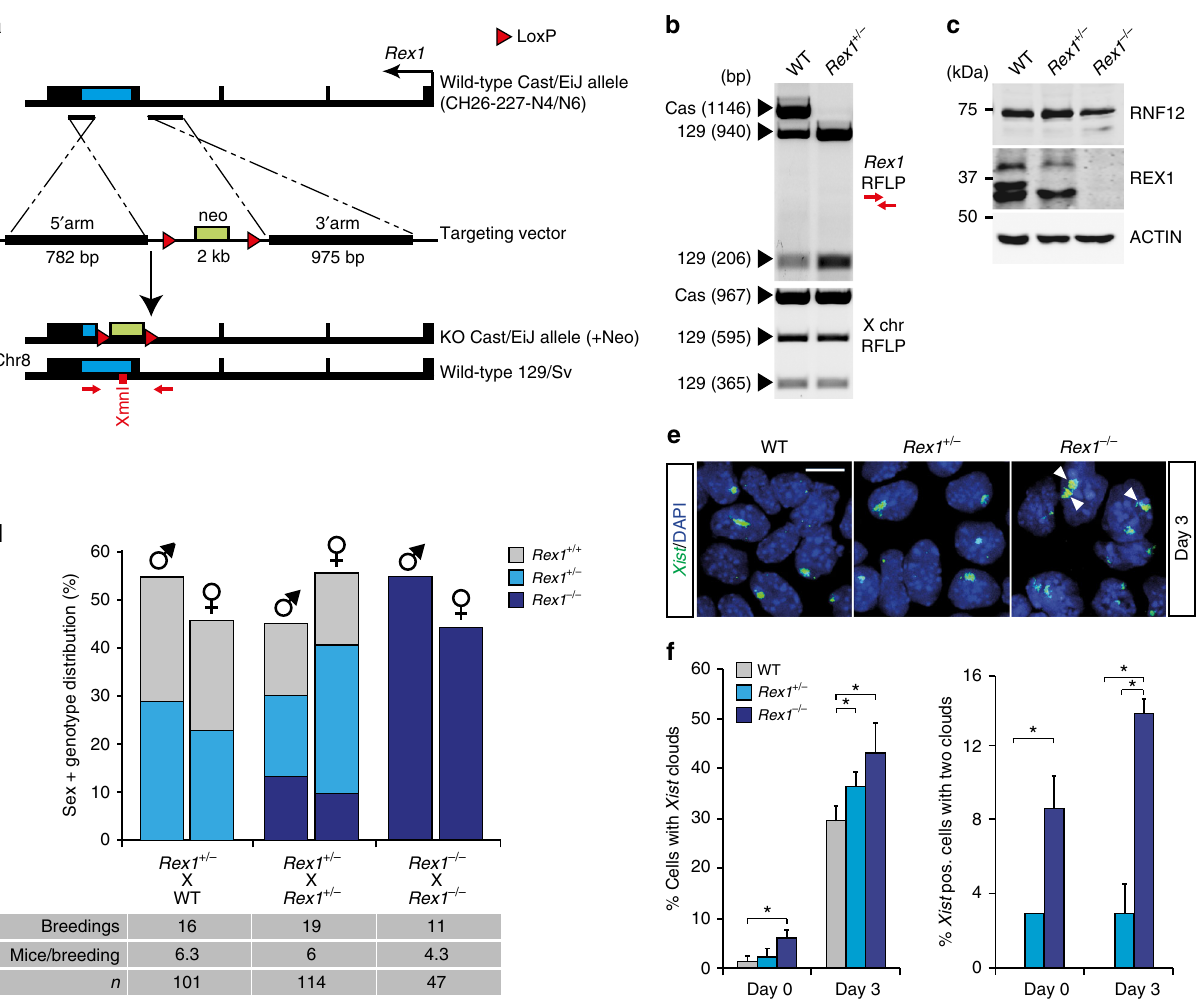
Fig. 2 Rex1 knockout mice are viable and fertile. a BAC targeting strategy to generate the Rex1 knockout cas allele in 129:cas ESCs. The Rex1 coding sequence is shown as a blue box. The start site is indicated by a black arrow. LoxP sites, denoted as red triangles, fl ank the neomycin-resistance gene (neo) as a positive gene selection marker. Primers used to validate gene recombination in ESCs and to genotype are shown as red arrows. b Validation of Rex1 knockout cas allele recombination by XmnI RFLP analysis of WT and Rex1 -targeted ESCs (top panel). Pf1M1 RFLP analysis to detect presence of two X chromosomes (bottom panel). c Nuclear extracts of WT, Rex1 + / − and Rex1 − / − ESCs were immunoblotted with RNF12 and REX1 antibodies. ACTIN was used as a loading control. Uncropped WB images are found in Supplementary Fig. 10b. d Sex and genotype distribution from different matings of Rex1 - de fi cient mice. Number of breedings, number of mice per breeding and total number of mice are indicated below. No signi fi cant bias against the birth of female animals was observed ( χ 2 test, p > 0.05). e Xist RNA-FISH (FITC) analysis on WT, Rex1 + / − and Rex1 − / − ESCs at day 3 of differentiation. DNA was stained with DAPI (blue). White arrows indicate the presence of two clouds within a nucleus. Scale bar: 20 μ m. f Quanti fi cation of Xist -positive cells (left panel) and Xist -positive cells with two clouds (right panel) in WT, Rex1 + / − and Rex1 − / − ESCs at day 0 and day 3 of differentiation. Asterisks indicate p - value <0.05, two-tailed Student's t test (average expression ± s.d., n = 1 – 3 biological Rex1 deletion rescues the lethality of Rnf12 − / − mice . To test showed proper XCR in the epiblast during pre-implantation development, as seen by the loss of H3K27me3 domains corre- whether stabilization of REX1 in Rnf12 mutant embryos might be sponding to the Xi (Fig. 5b). Also, IF staining detecting related to the lethality associated with maternal transmission of Rnf12 mutant alleles, we crossed our Rnf12 KO mice and Rex1 H3K27me3 and OCT4 revealed normal XCR in PGCs (Supple- mentary Fig. 9b, c), suggesting that reactivation of the Xi is KO mice to generate Rnf12 − / − :Rex1 − / − DKO mice. In contrast to Rnf12 − / + or Rnf12 − / − mice that were never obtained in a Rex1 normal in Rnf12 − / − :Rex1 − / − female blastocysts and embryos. WT or heterozygous background, several Rnf12 − / + :Rex1 − / − and We then investigated iXCI and rXCI in Rnf12 − / − :Rex1 − / − Rnf12 − / − :Rex1 − / − female mice were born (Fig. 5a; Supplemen- blastocysts, embryos and adults. REX1 and H3K27me3 IF tary Fig. 9a). In general, litters were smaller, but no gender or staining of Rnf12 − / − :Rex1 − / − blastocysts showed normal iXCI allele bias was observed (Fig. 5a). We con fi rmed these results by (H3K27me3 domains corresponding to the Xi) compared to WT crossing Rnf12 + / − :Rex1 − / − or Rnf12 − / − :Rex1 − / − females with blastocysts (Fig. 5b), in line with Xist RNA-FISH analysis in Rex1 − / + males, whose Rnf12 − / + :Rex1 − / − daughters were viable trophoblast cells of Rnf12 − / − :Rex1 − / − blastocyst outgrowths but their Rnf12 − / + :Rex1 − / + sisters were not (Supplementary (Supplementary Fig. 7a, b), indicating that iXCI in Rnf12 − / − : Rex1 − / − blastocysts is normal. Allele-speci fi c RT-PCR analysis Fig. 9a). IF staining on Rnf12 − / − :Rex1 − / − E4.5 female blastocysts from compound homozygous crosses con fi rmed loss of REX1 and examining Xist , G6pdx and Mecp2 expression on RNA isolated